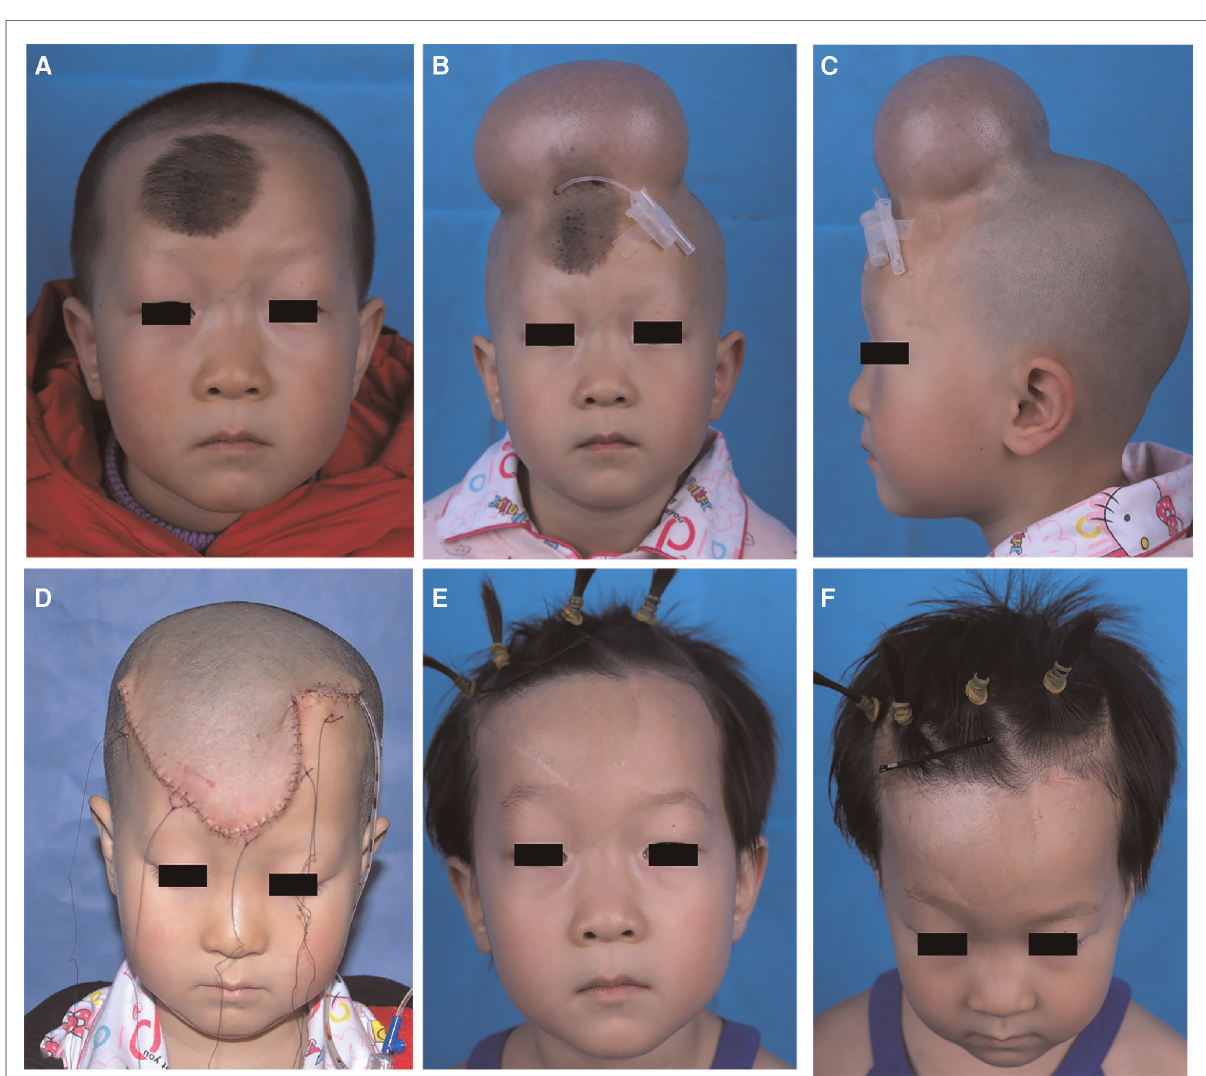
FIGURE 2 Case 1 ( A ), a 4-year-old girl with congenital nevus (5×4 cm 2 ) on forehead. ( B,C ), a 300 ml cylindrical expander was implanted under the scalp near the lesion, the fi nal expansion volume was 415 ml. ( D ), the expander was removed and expanded scalp fl ap was transferred to cover the facial defect. ( E,F ), 5-months postoperative view after 3 sessions of laser hair